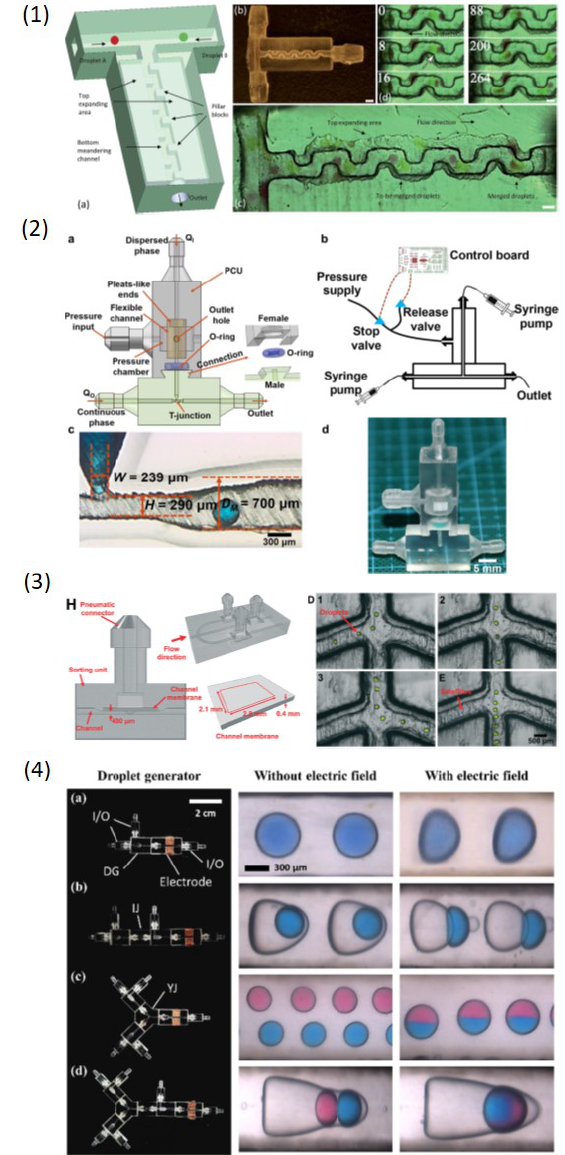
Figure 9. ( 1 ) Pneumatic control of droplet formation through a 3D-printed flexible membrane. ( 2 ) Pneumatic control of droplet sorting through a 3D-printed flexible valve. ( 3 ) Droplet coalescence in a 3D-printed channel consisting of a top layer for flow drainage and a bottom rail layer for droplet guide. ( 4 ) Droplet deformation, release and coalescence in a 3D-printed channel through an external electric field. Reproduce of